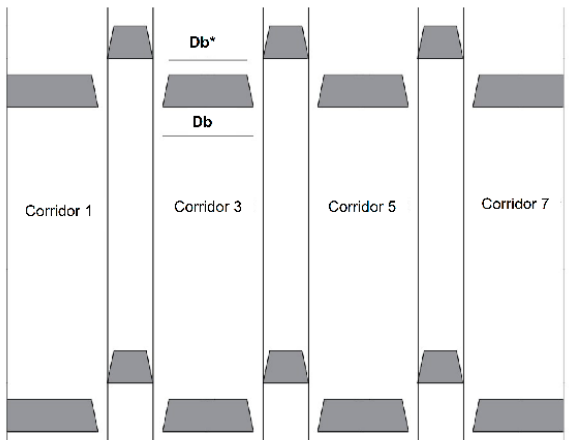
Figure 6. Detail of trapezoidal boulder dimension of double trapezoidal boulder layout (DT3). * indicates the shorter base of the trapezoid.